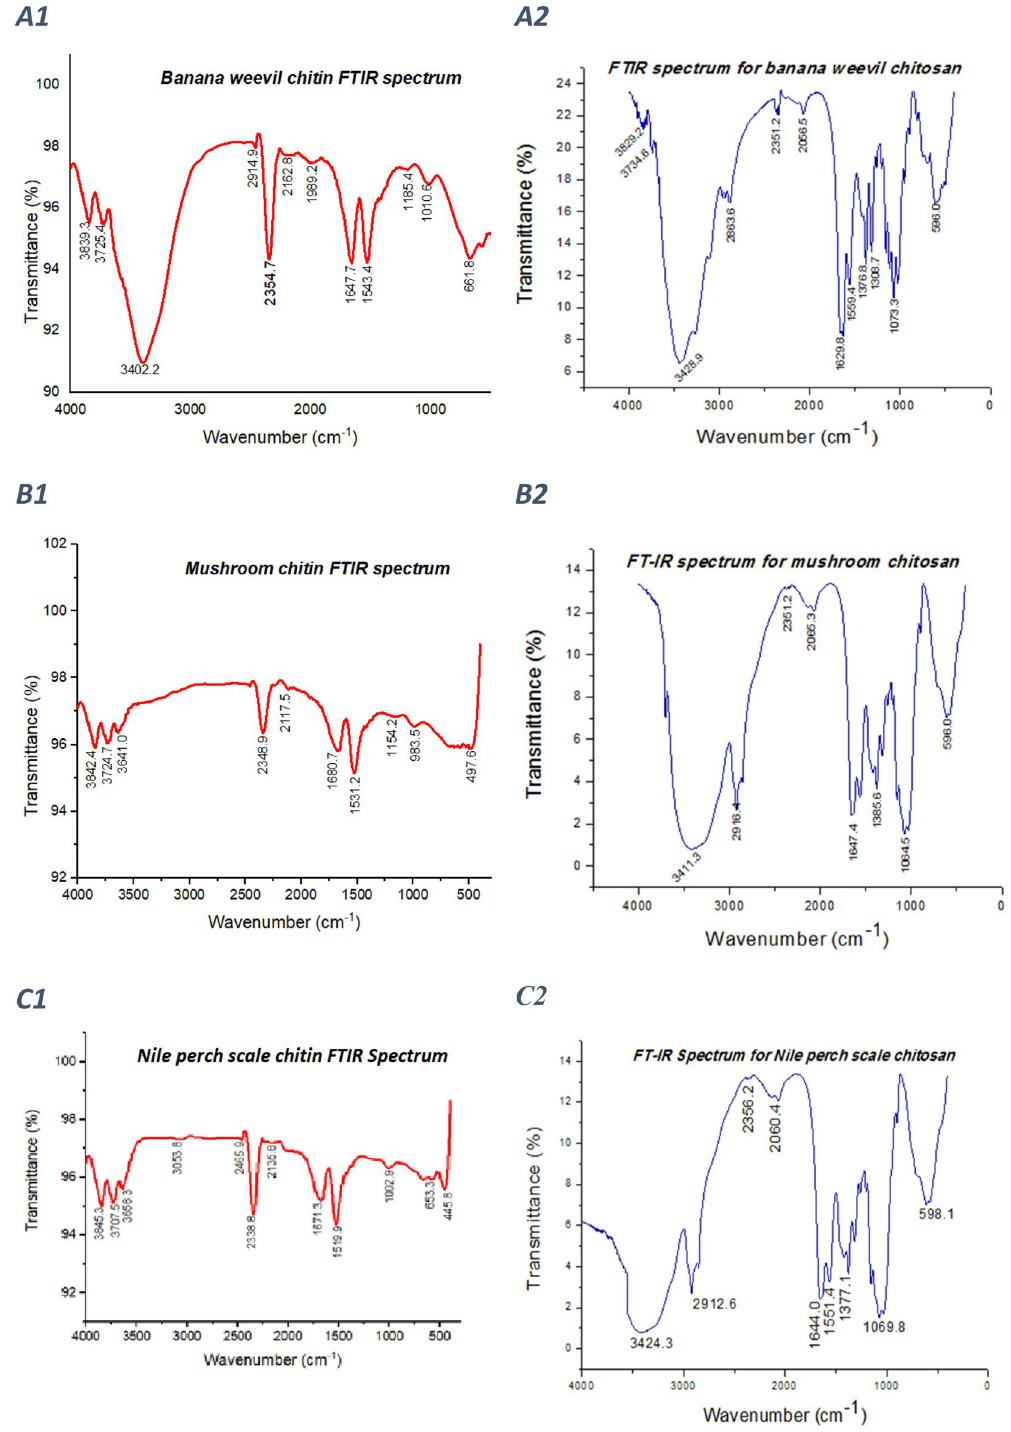
Figure 1. FTIR spectra for chitin and chitosan isolated from locally available materials; ( A1 ) Banana weevil chitin FTIR spectrum, ( A2 ) banana weevil chitosan FTIR spectrum, ( B1 ) mushroom chitin FTIR spectrum, ( B2 ) mushroom chitosan FTIR spectrum, ( C1 ) Nile perch scale chitin FTIR spectrum, ( C2 ) Nile perch scale chitin FTIR spectrum, ( D1 ) commercial chitin FTIR spectrum, and ( D2 ) commercial chitosan FTIR